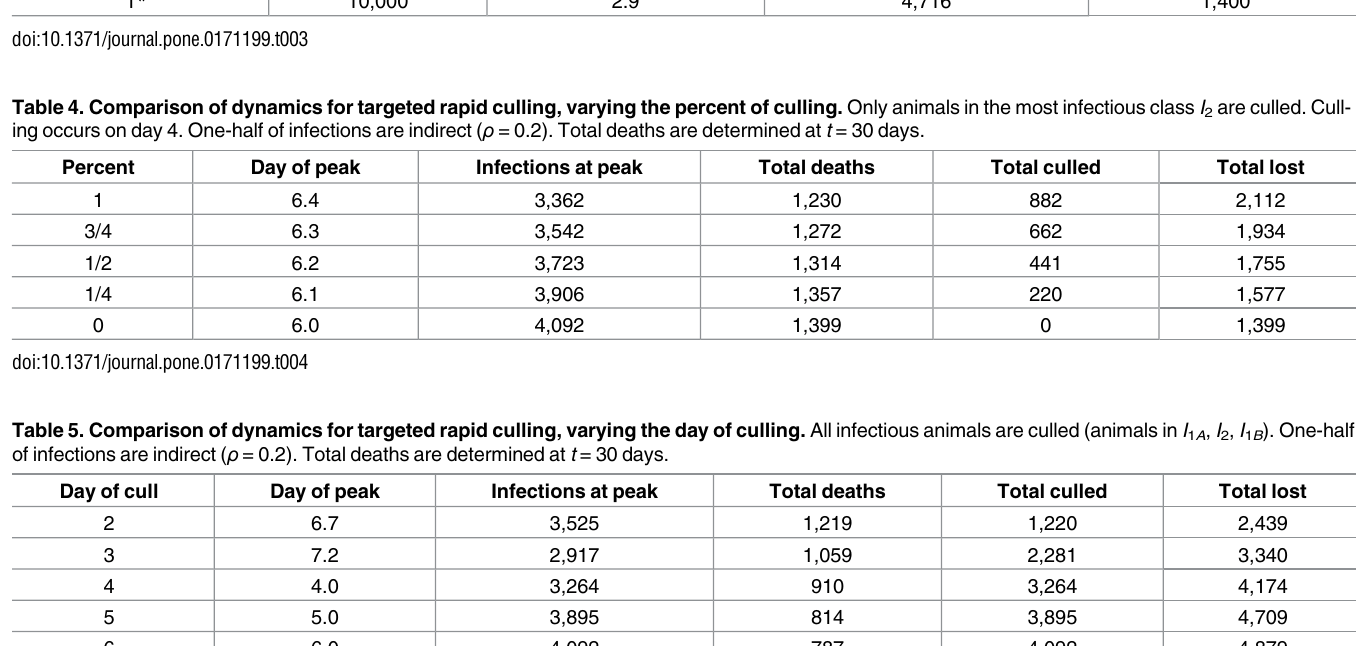
Table 4. Comparison of dynamics for targeted rapid culling, varying the percent of culling. Only animalsin the most infectiousclass I 2 are culled.Cull- ing occurs on day 4. One-half of infectionsare indirect ( ρ = 0.2). Total deaths are determinedat t = 30 days. Percent Day of peak Infections at peak